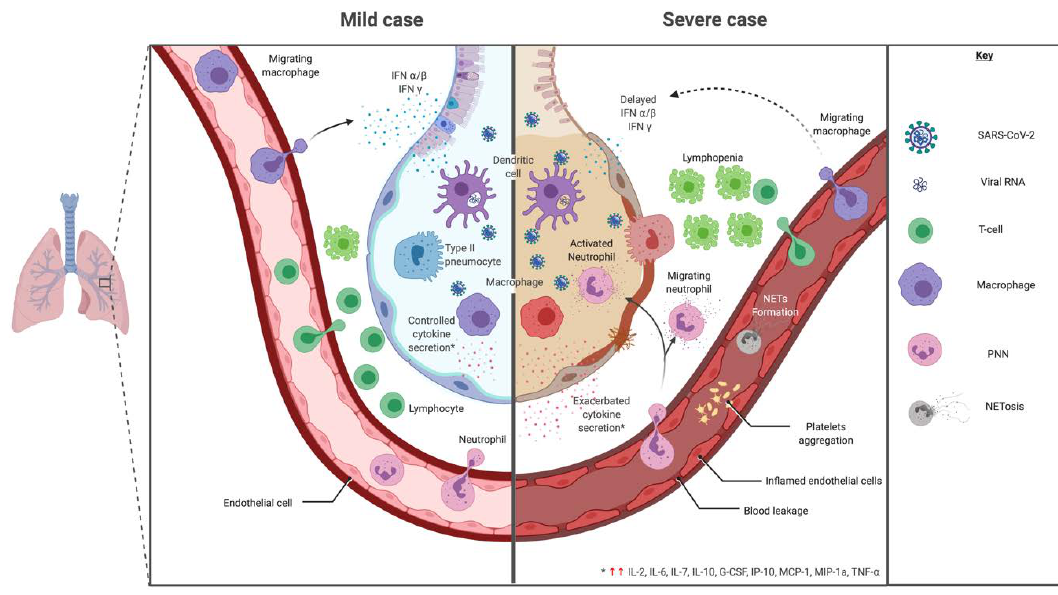
Figure 4. Mild versus severe immune response during SARS-CoV-2 infection. In regards to cytokine